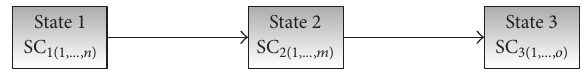
Figure 5: Basic three-process model with disruptive state transfor- mations implied processes.